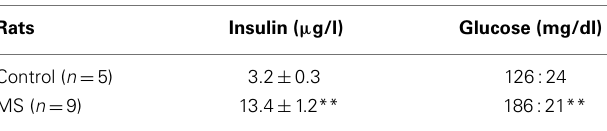
Table 2 | Plasma insulin and glucose measurements of control and MS rats